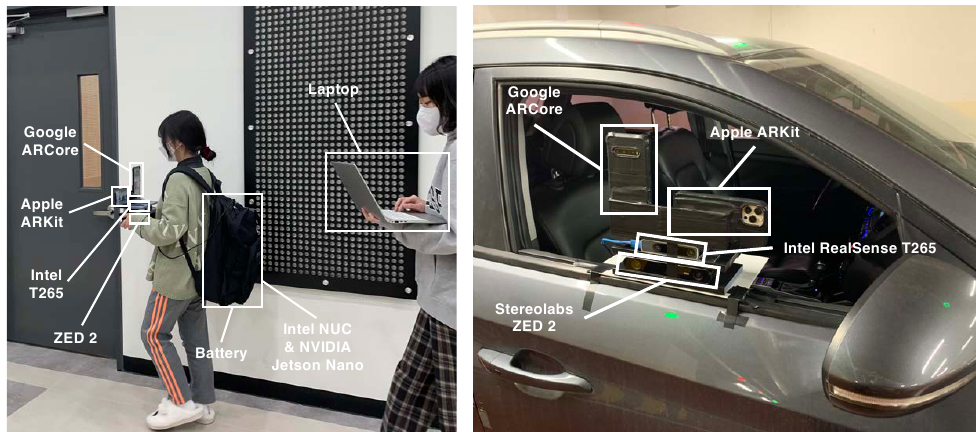
Figure 3. We carried the custom-built capture rig by hand and stored the computers and batteries to collect the indoor 6-DoF motion data from the VI sensors ( left ). In the outdoor vehicular tests, we fixed the capture rig to the front passenger seat ( right ).